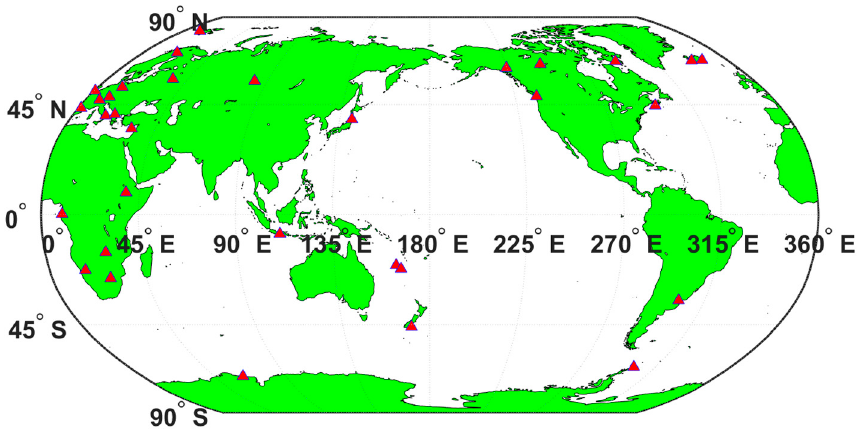
Figure 7. The distribution of the selected IGS stations for static PPP tests.